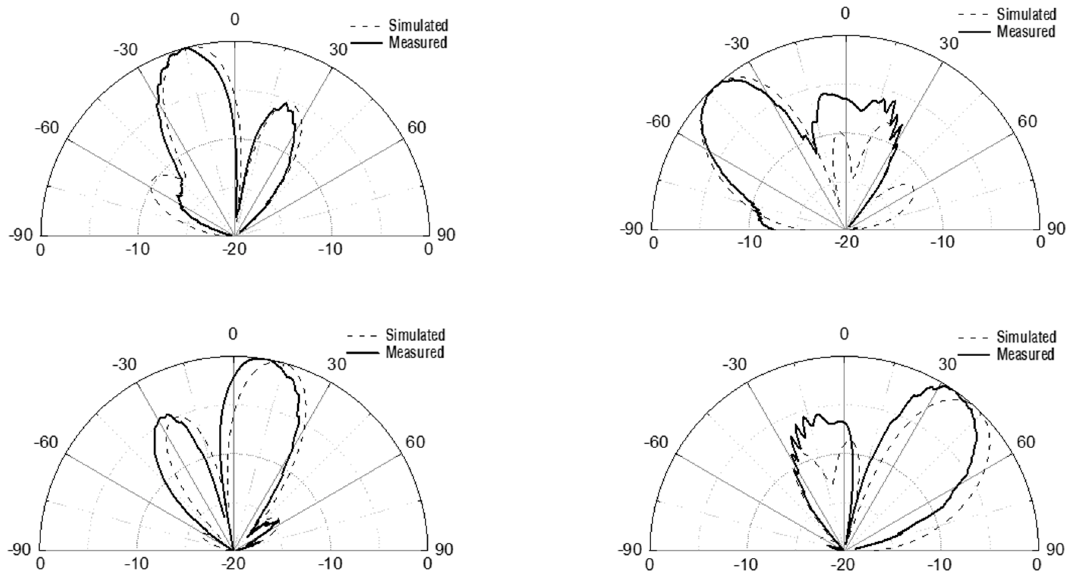
Figure 9. Measured and simulated radiation patterns of four directional beams in 28 GHz.